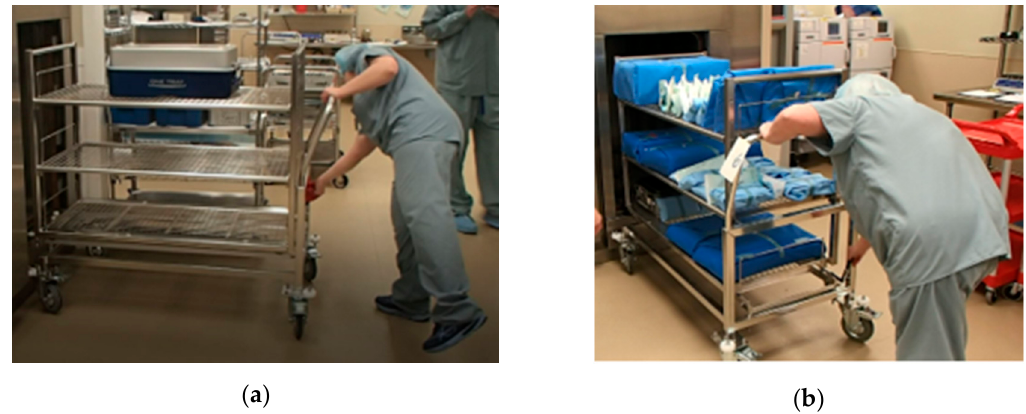
Figure 5. Carts going into the steam sterilizer: ( a ) Cart with one tray, ( b ) Cart at full capacity.